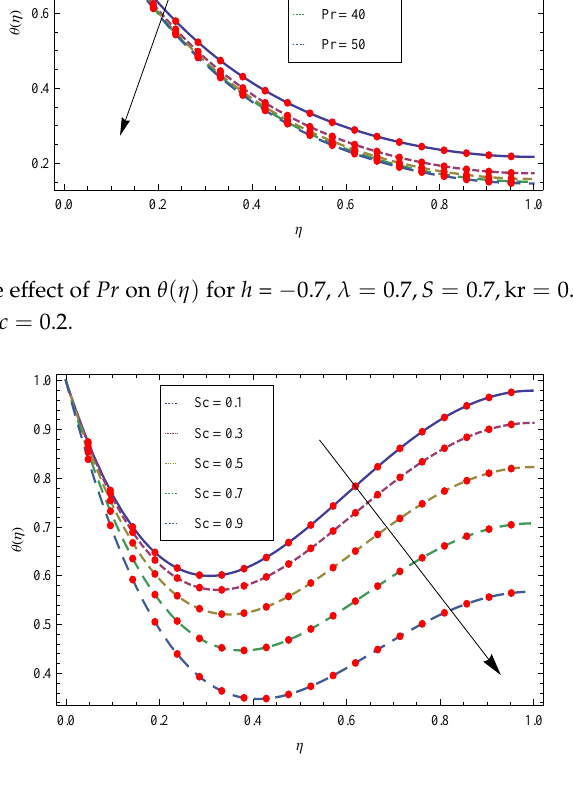
Figure 15. Shows the effect of Sc on θ ( η ) for h = − 0.9, λ = 0.7, S = 0.7,kr = 0.7,Pr = 30, Ec = 0.7, Nb = 0.5,Nt = 0.7, β = 1 and Sc =